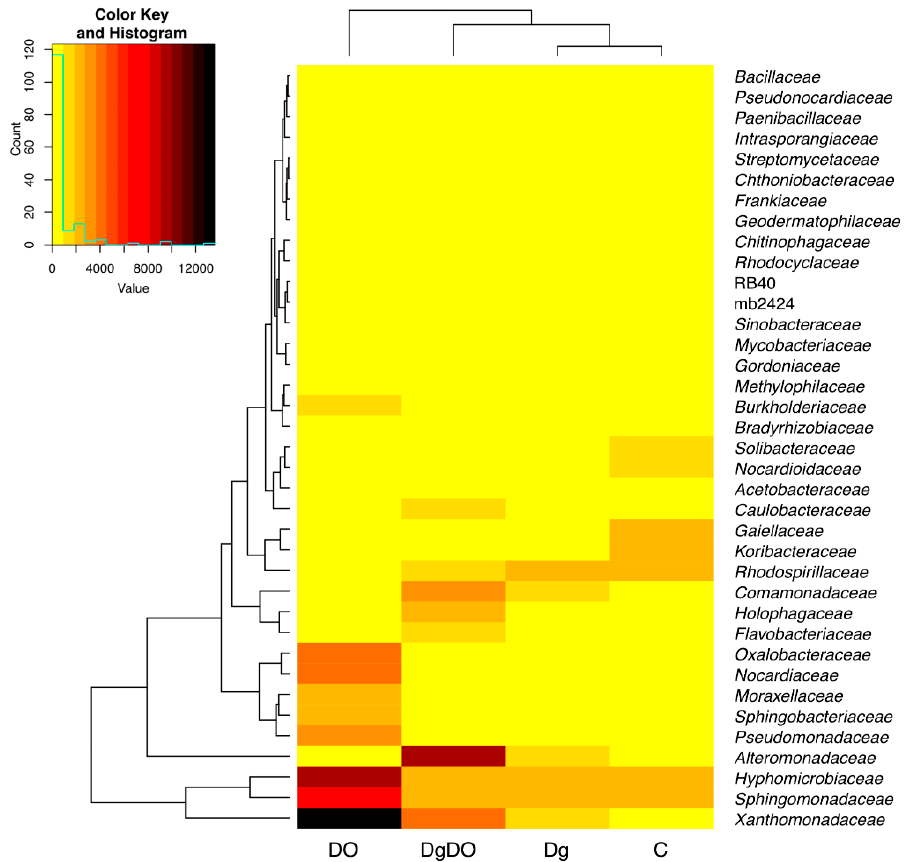
Figure 6. Heat map and relationships of the operational taxonomic unit (OTU) numbers of 37 bacterial families in the soil with a difference between proportions ≥ 1% . C—non-polluted and non-sown soil, Dg—non-polluted soil sown with Dactylis glomerata , DO—non-sown soil polluted with diesel oil, DgDO—soil polluted with diesel oil and sown with Dactylis glomerata